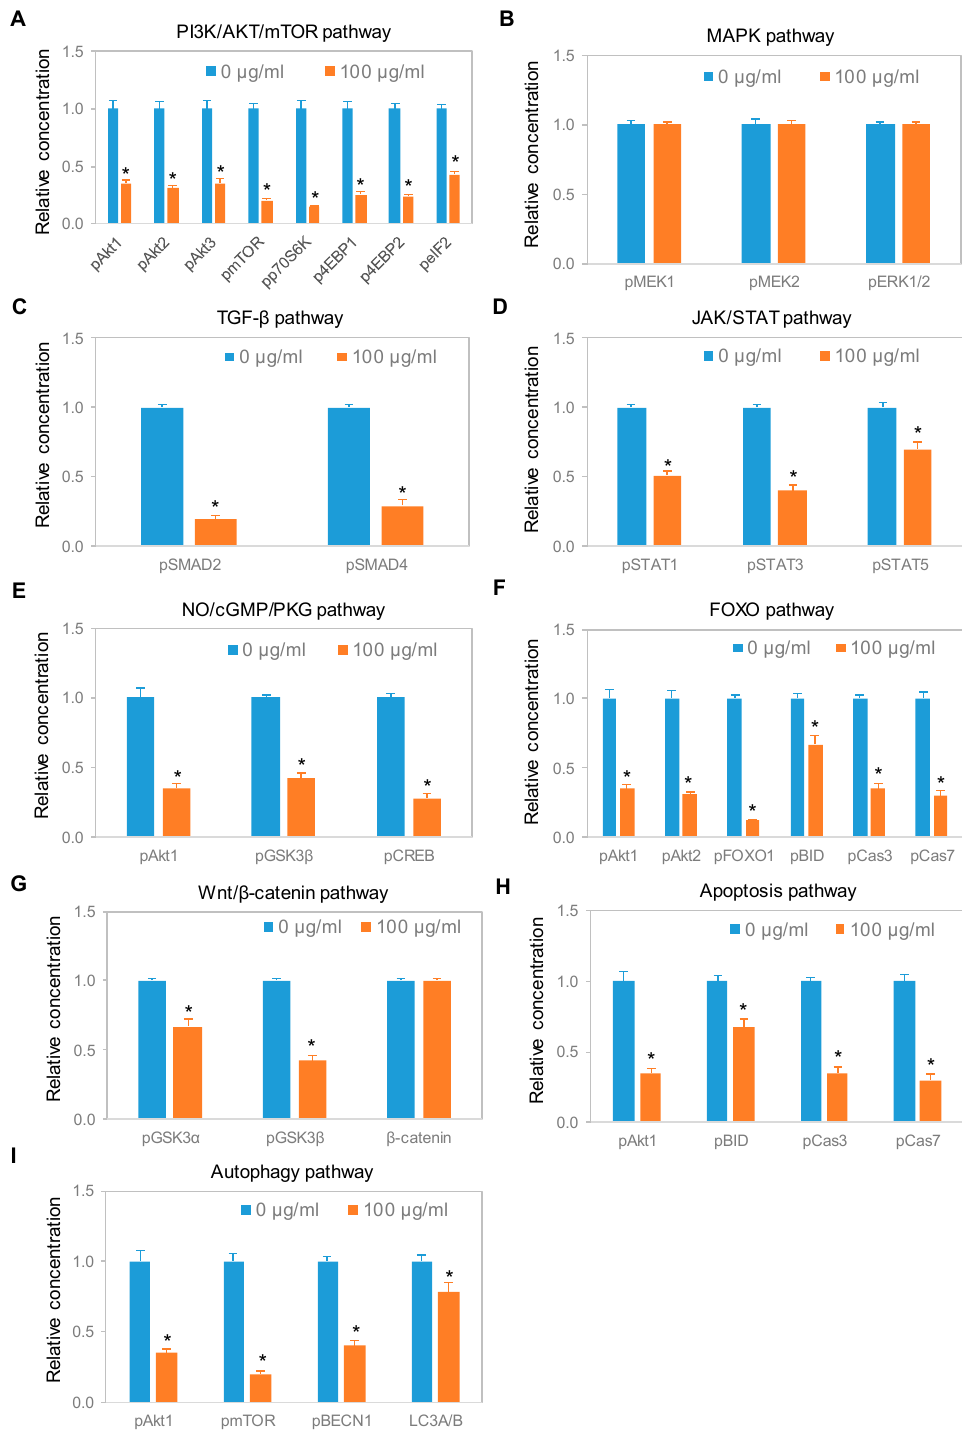
Figure 7. Expression of protein isoforms in selected signaling pathways following treatment with a CBD oil. ( A ) PI3K/Akt/mTOR pathway; ( B ) MAPK pathway; ( C ) TGF- β pathway; ( D ) JAK/STAT pathway; ( E ) NO/cGMP/PKG pathway; ( F ) FOXO pathway; ( G ) Wnt/ β -catenin pathway; ( H ) apoptosis pathway; and ( I ) autophagy pathway. Blue and orange are control samples (0 µg/mL) and samples treated with CBD oil V1 at 100 µg/mL final CBD concentration for 24 h, respectively. Relative concentration describes fold change of protein phosphoisoforms after treatment as compared with the control. Error bars are standard deviations across six repeated measurements per experimental condition. Asterisks indicate statistical significance for p ≤ 0.05 versus control.